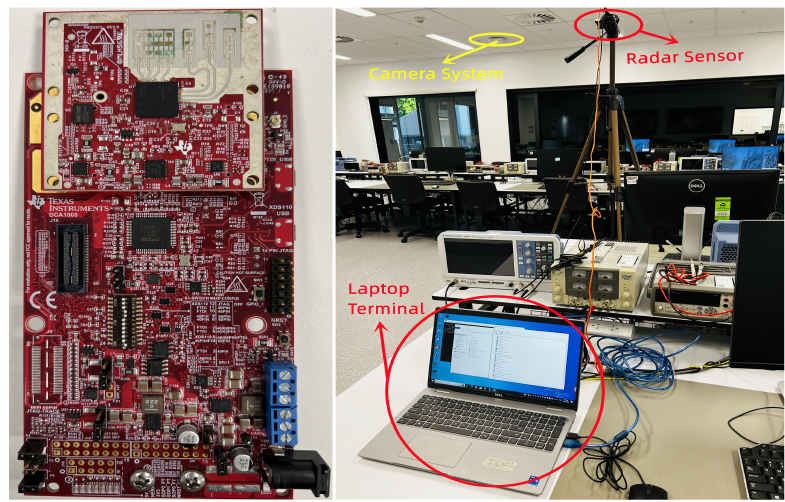
Figure 5. Experiment Setup. IWR6843 Sensor and Experiment